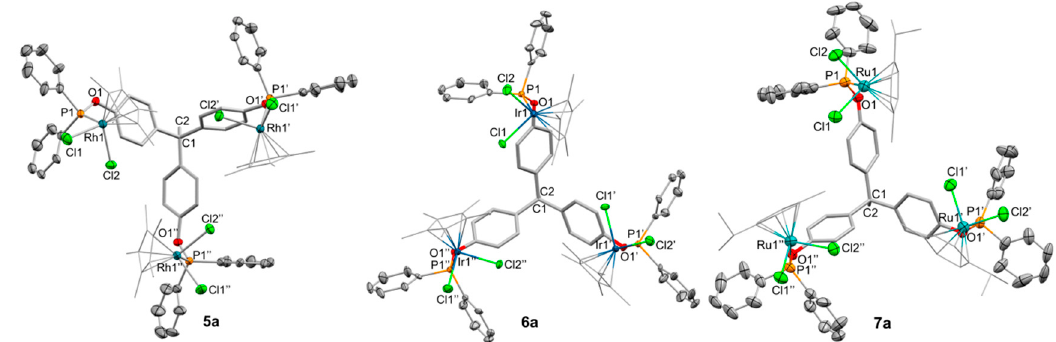
Figure 4. ORTEP view of the solid structure of compounds 5a , 6a, and 7a with thermal ellipsoids set at 50% probability. Hydrogen atoms and solvent molecules have been excluded for the sake of clarity. Selected bond distances (Å) and angles ( ◦ ): Compound 5a : Rh1–P1, 2.2829(16);